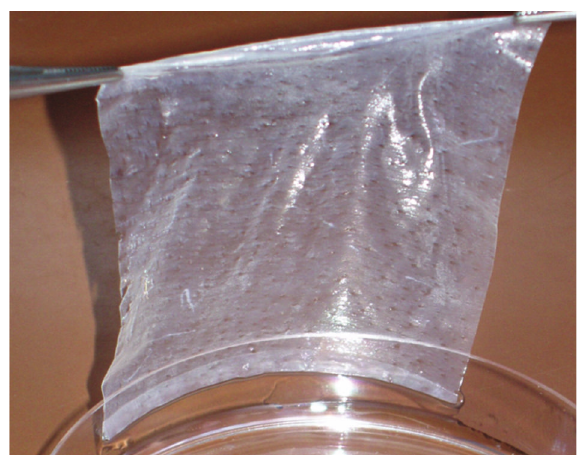
Figure 1: Acellular porcine dermis Xe-Derma. Hydrated XD has properties similar to those of normal human